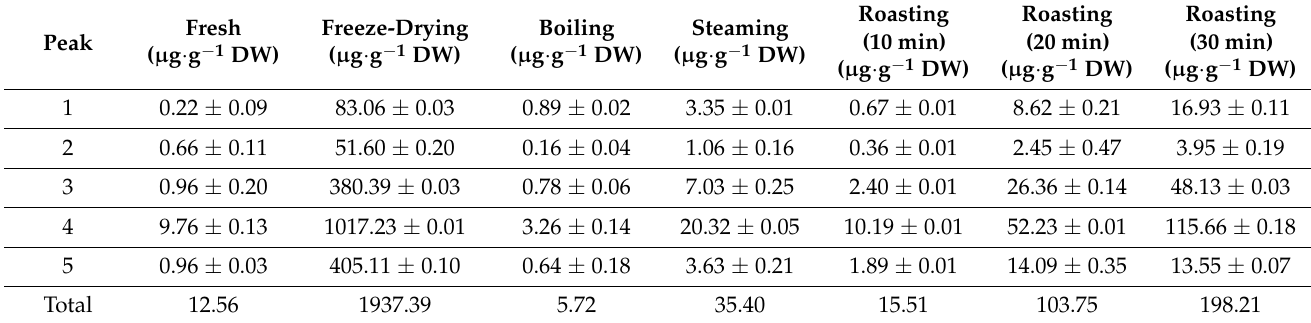
Table 3. Effect of the cooking on anthocyanins identified and quantified by HPLC-DAD.